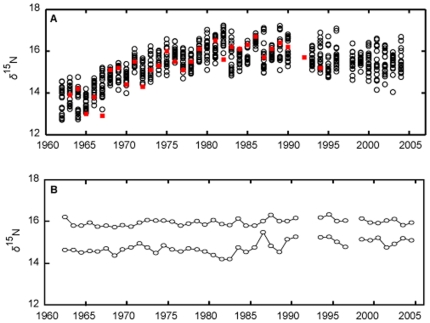
Measured and simulated time-series of δ
15N.(a) Open circle and red squares represent individual values measured in the present study and Ogawa et al [19], respectively. (b) Two lines represent the maximum and minimum values of δ
15N, respectively, calculated from the maximum or minimum values of total body length of each sampling year using the time-averaged size-trophic relationship (the blue line in Figure 2).